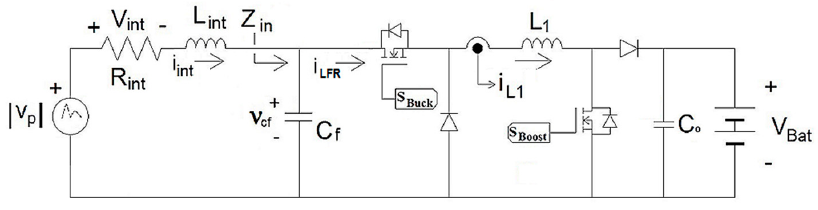
Figure 10. Buck/Boost Hybrid Converter (HBB). Figure 10. Buck / Boost Hybrid Converter